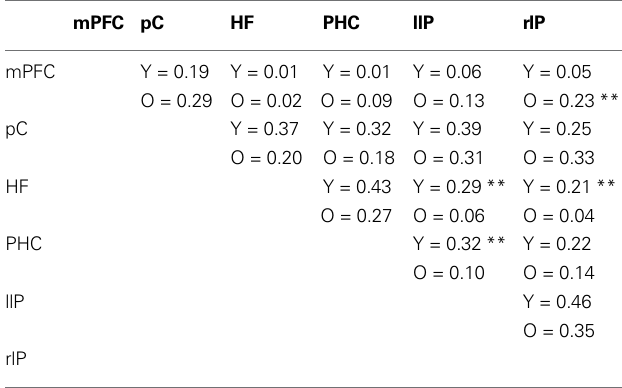
Areas include medial prefrontal (mPFC), posterior cingular cortex (pC), hippocampal formation (HF), parahippocampal cortex (PHC), and left and right lateral parietal lobe (llP and rlP, respectively). **Indicates a statistically signifi cant difference between the two age groups after correcting for 15 multiple